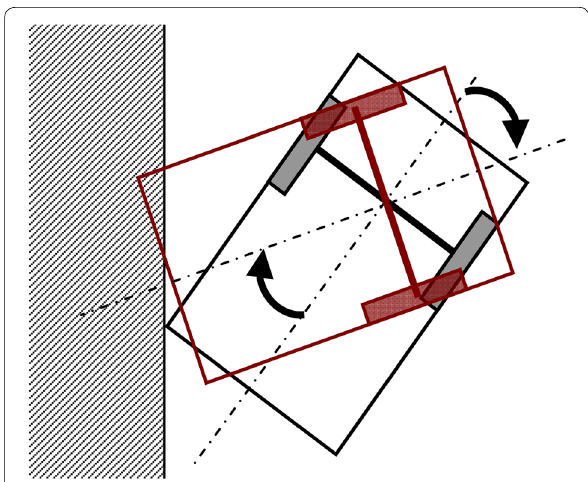
Fig. 5 Repeated collisions by turnings at a fixed position